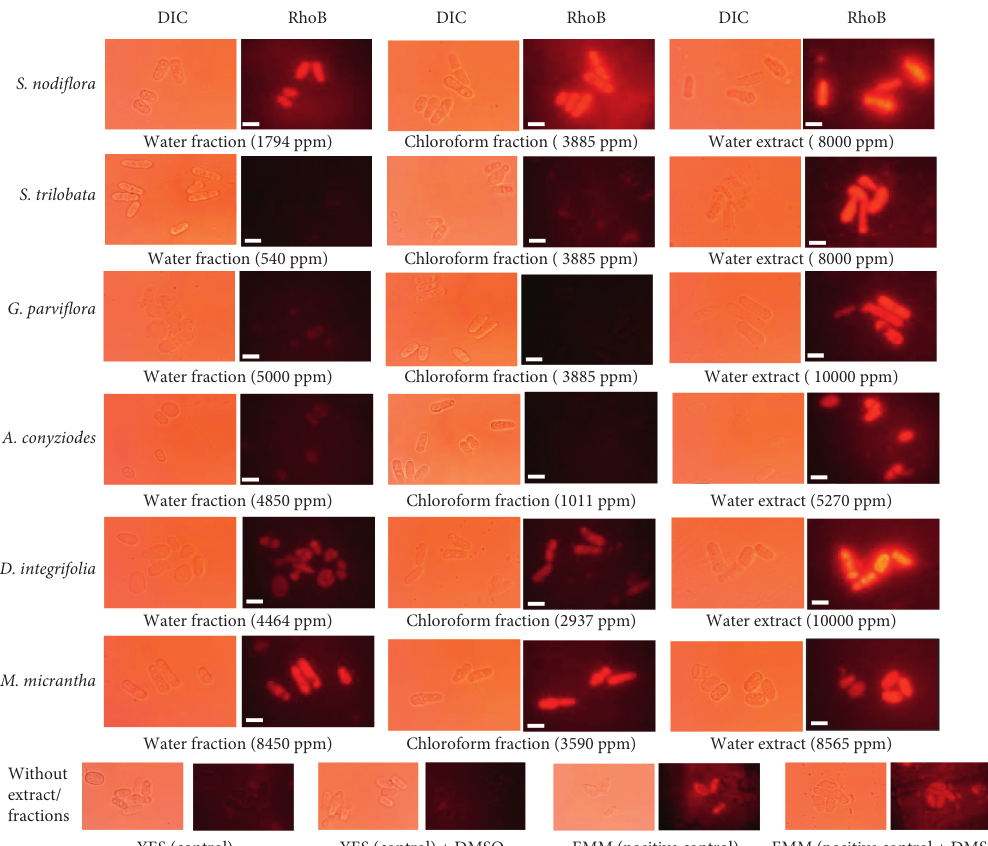
Figure 4: Effect of plant extract/fractions on the yeast mitochondrial activity. Yeast was grown in YES broth medium containing various concentrations of extract/fractions. Cells were then harvested and suspended with phosphate buffer. Mitochondrial activity was identified using Rhodamine 123 as a probe under fluorescence microscopy observation.